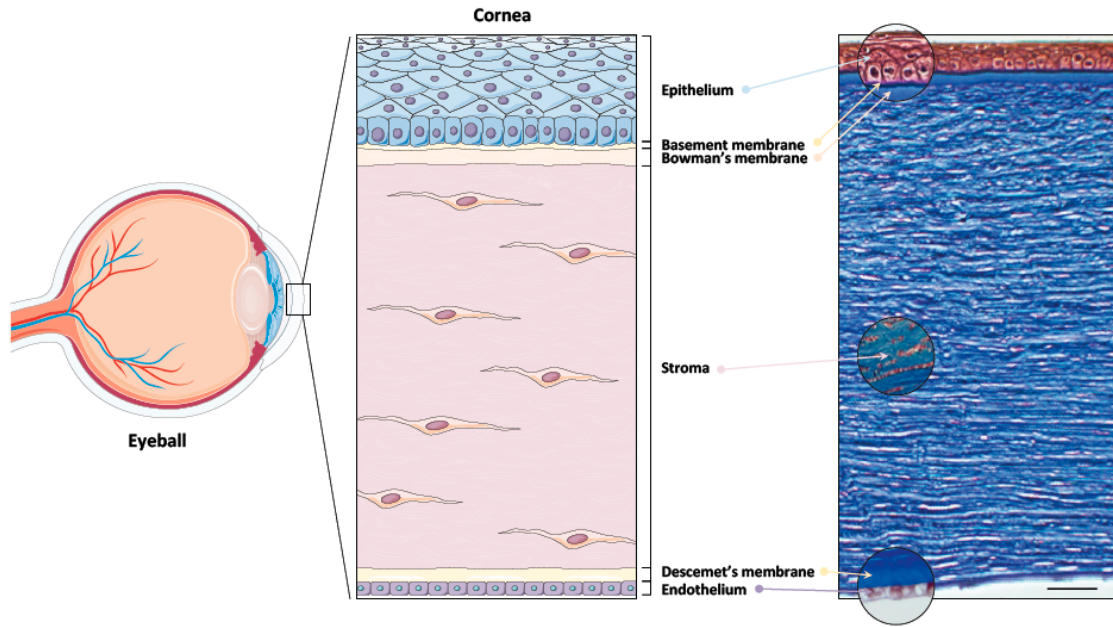
Figure 1. Schematic of the human cornea and histology. Left panel: Schematic view of the human eye. The cornea forms the transparent front part of the eyeball. Central panel: From anterior to posterior, the cornea is made up of a stratified squamous epithelium deposited on a basement membrane, follows the Bowman’s membrane, a stroma, composed predominantly of collagen fibrils in which keratocytes are entangled, the Descemet’s membrane, and a monolayer of endothelial cells. Right panel: Masson trichrome staining of a section of the entire native human cornea showing all cellular compartments of that tissue. Scale bar: 50 µ